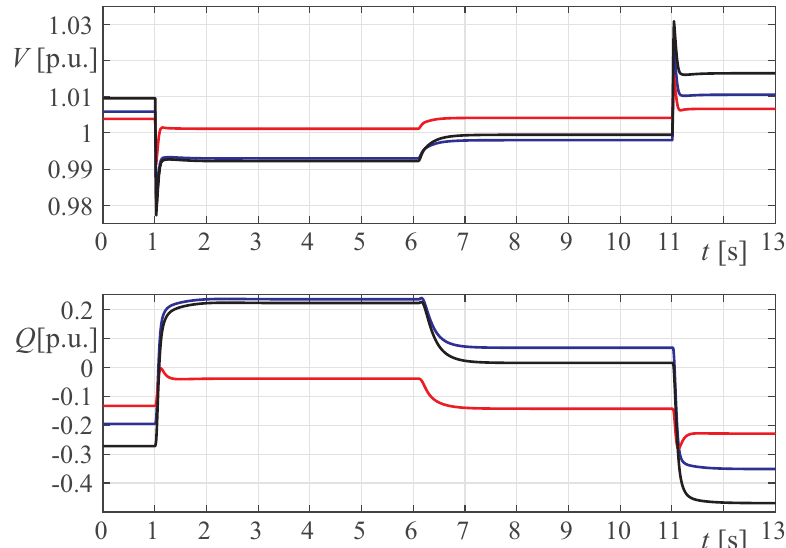
Figure 7. First simulation, Feeder 1: time evolution of the nodal voltage amplitudes ( V 6 blue, V 11 red, V 13 black) and PV reactive powers ( Q DG